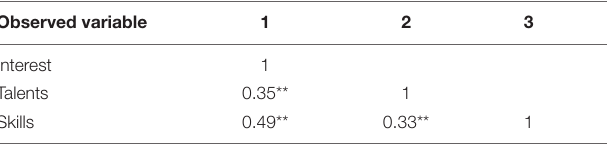
TABLE 9 | Correlations among “A person is born with specific ...